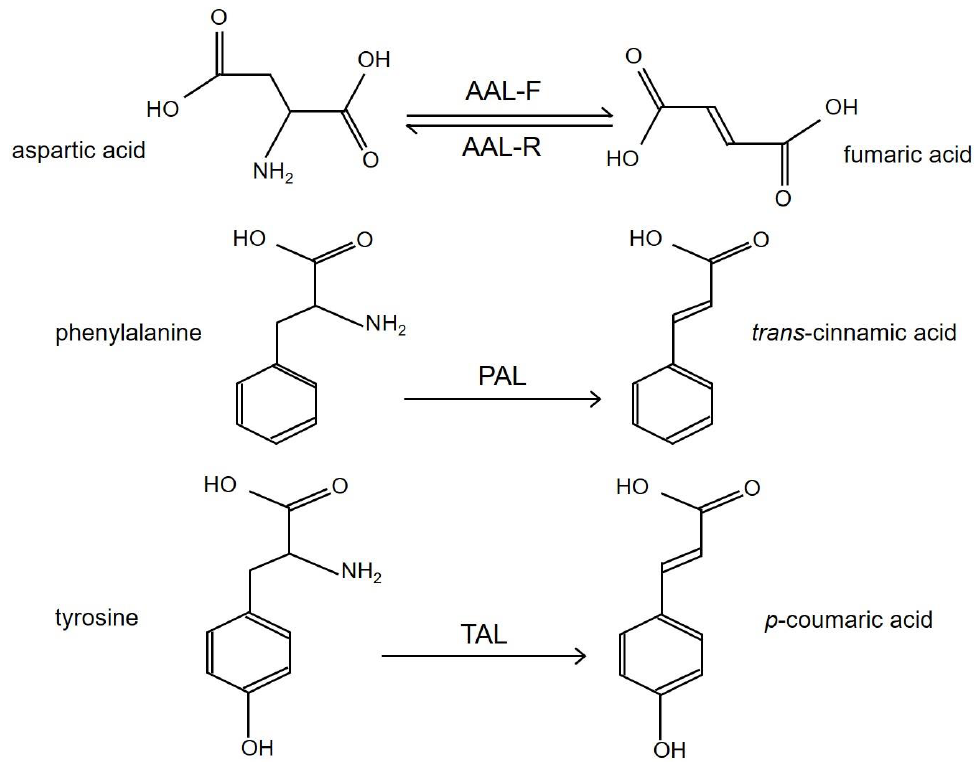
Figure 1. The enzyme reactions catalyzed by the LpAAL protein. AAL-F: aspartate ammonia-lyase forward reaction; AAL-R: aspartate ammonia-lyase reverse reaction; PAL: phenylalanine ammonia- lyase; TAL: tyrosine ammonia-lyase.